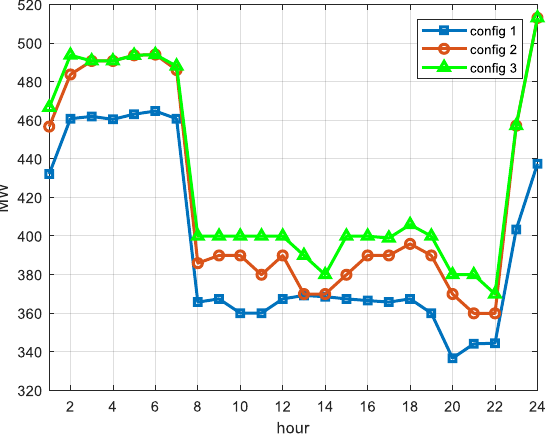
ff erent system configurations.